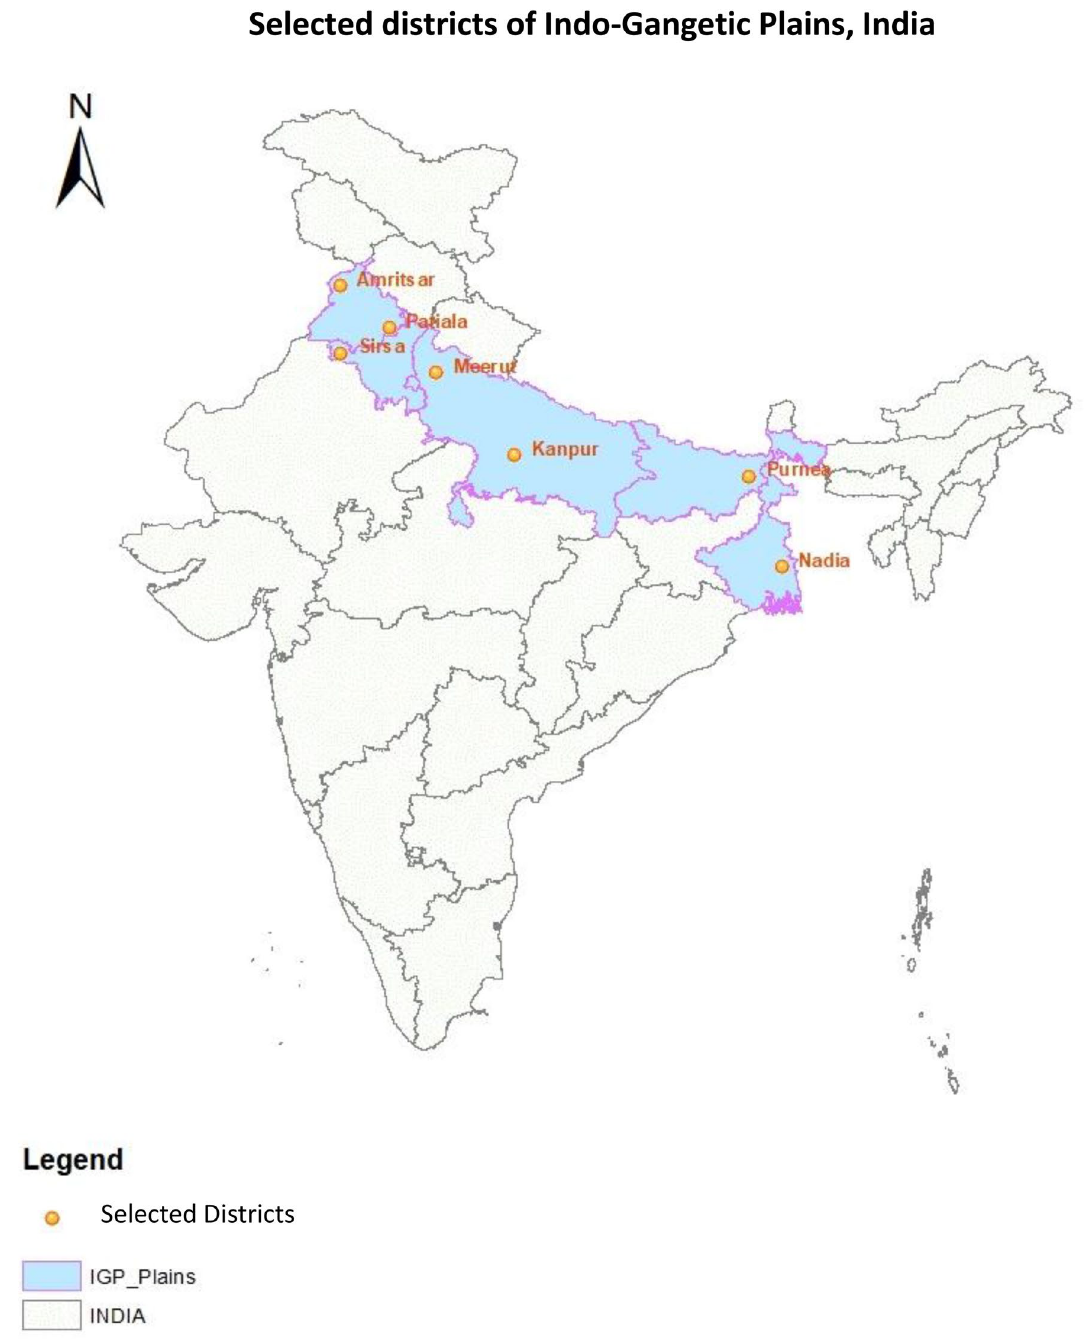
Figure 1. Map of study locale with selected districts of Indo-Gangetic Plains of